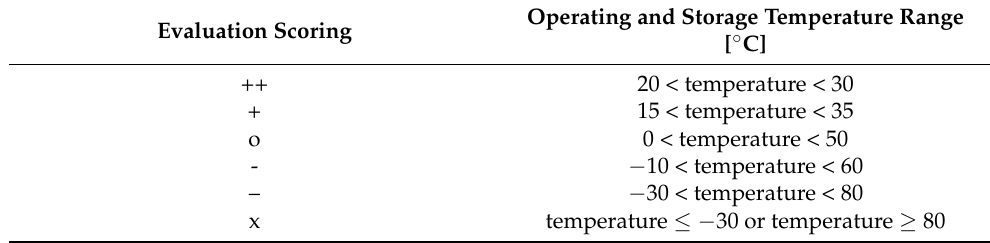
Table A4. Conversion table used for the operating and storage temperature range.